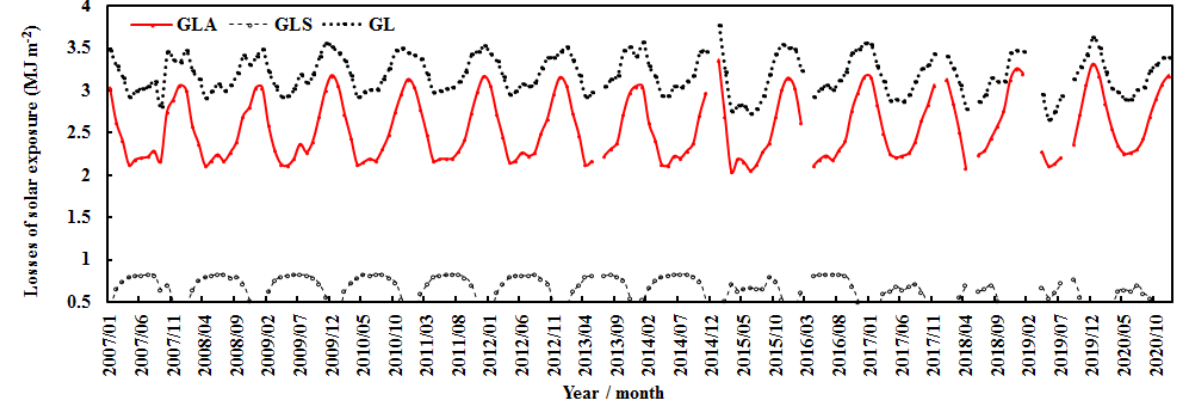
Figure 7. Monthly losses of global solar exposure caused by absorbing and scattering substances (G LA and G LS ) and total loss (G L = G LA + G LS ) at the Qomolangma site.